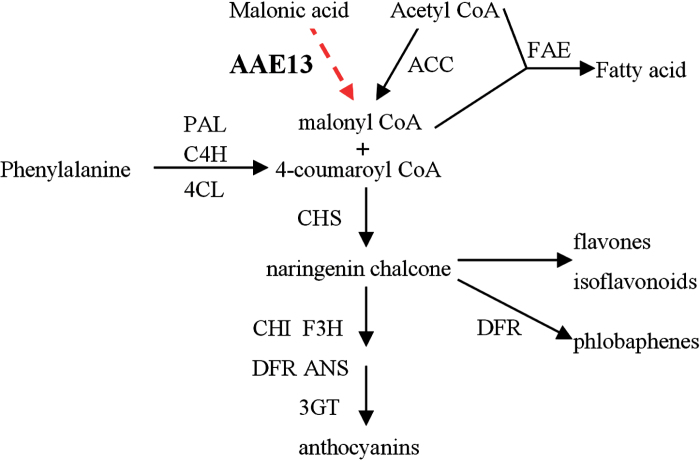
A simplified view of the anthocyanin biosynthesis pathway (Koes et al., 2005; Rausher et al., 1999). 3GT, UDP-glucose:flavonoid 3-O-glycosyl transferase; 4CL, 4-coumarate:CoA ligase; AAE13, acyl-activating enzyme 13 (malonyl-CoA synthetase); ACC, acetyl-CoA carboxylase; ANS, anthocyanin synthase; C4H, cinnamate-4-hydroxylase; CHS, chalcone synthase; CHI, chalcone flavanone isomerase; DFR, dihydroflavonol 4-reductase; F3H, flavanone 3β-hydroxylase; FAE, fatty acid elongase; PAL, phenylalanine ammonia-lyase.